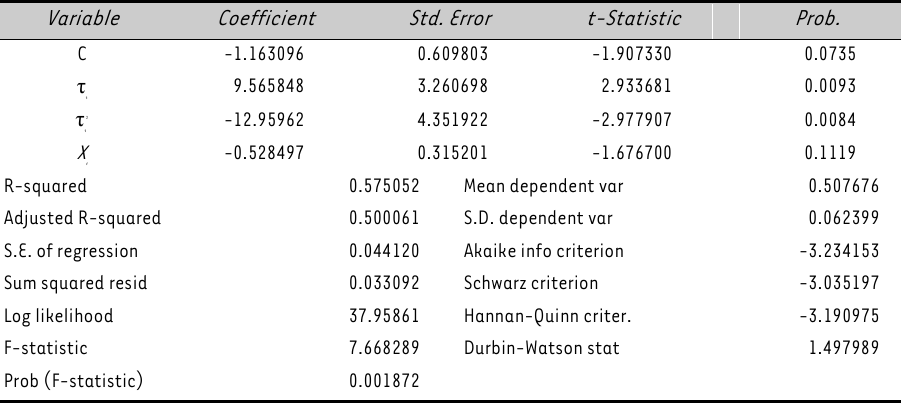
Results of regression